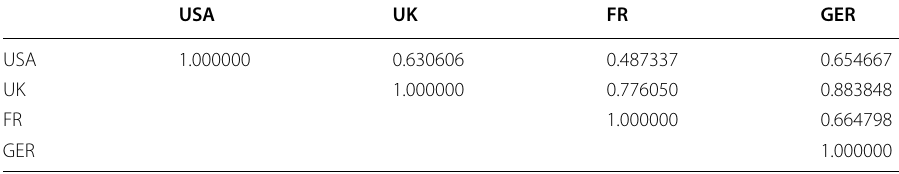
Table 2 Correlation matrix in the full